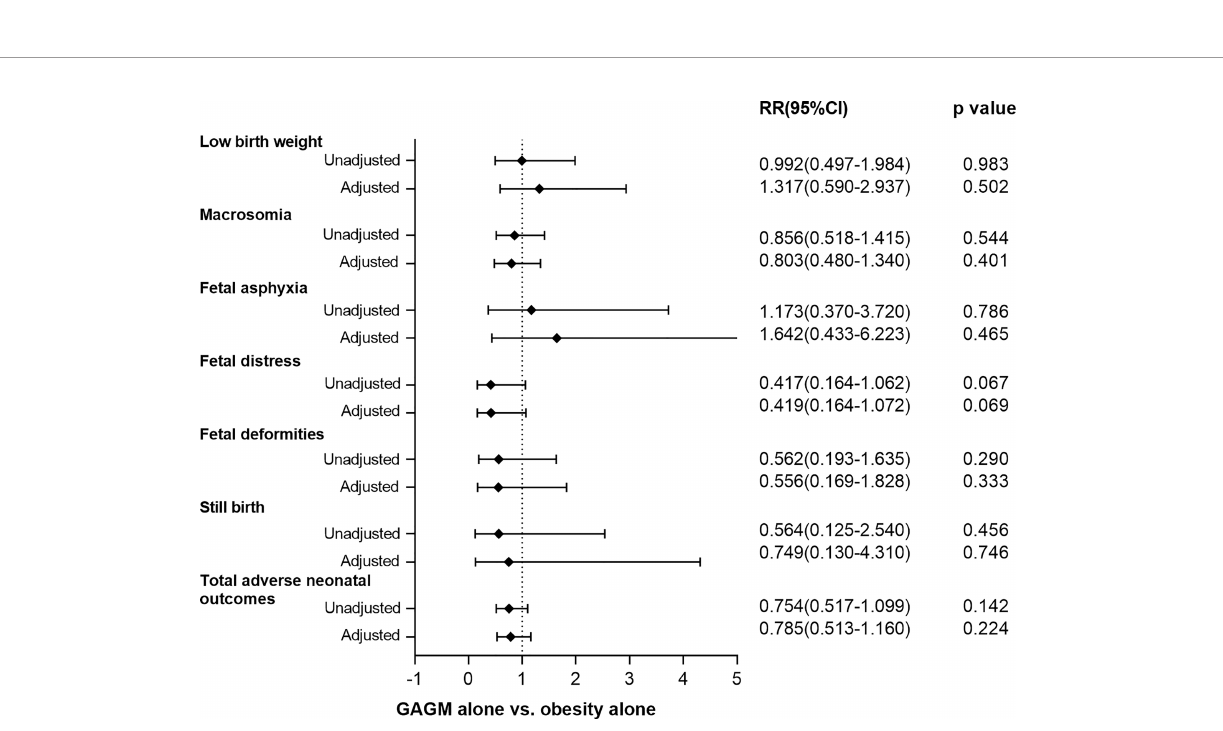
FIGURE 2 | Comparison of adverse neonatal outcomes between pre-pregnancy obesity alone and GAGM alone. Adjusted: adjusted for maternal age, gestational age, and primiparity. Adjusted a : adjusted for maternal age, and